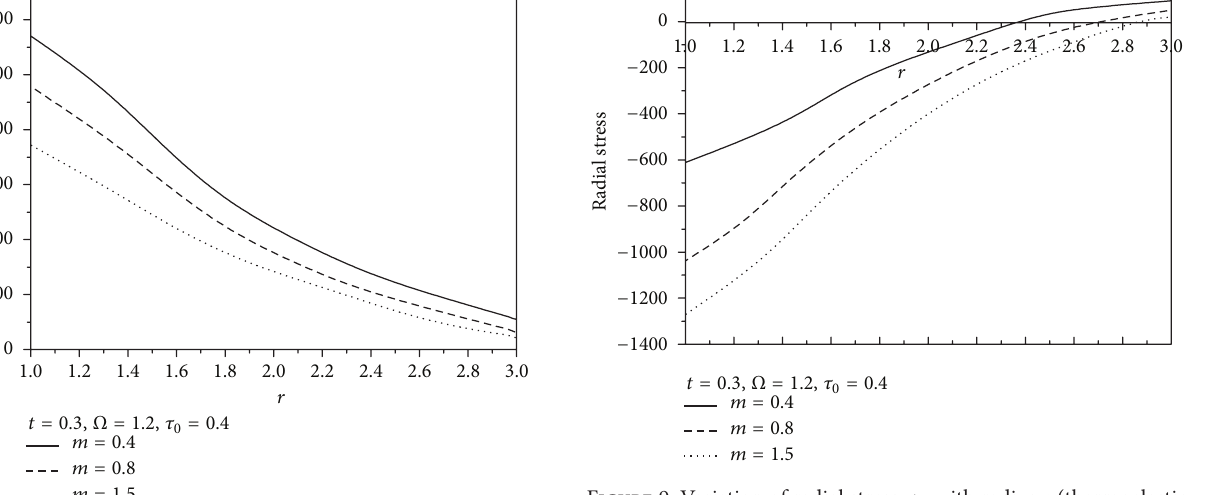
Figure 9: Variation of radial stress 𝜎 𝑟𝑟 with radius 𝑟 (thermoelastic nonhomogeneity medium).